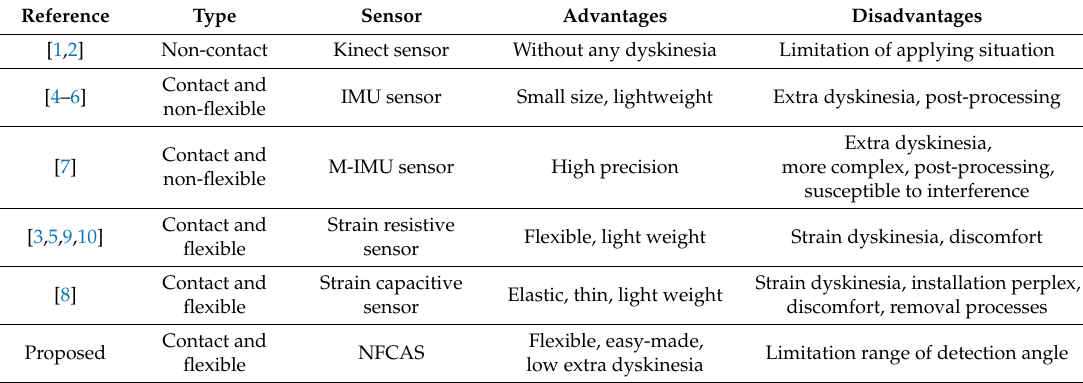
Table 1. Comparison of different human body motion detecting